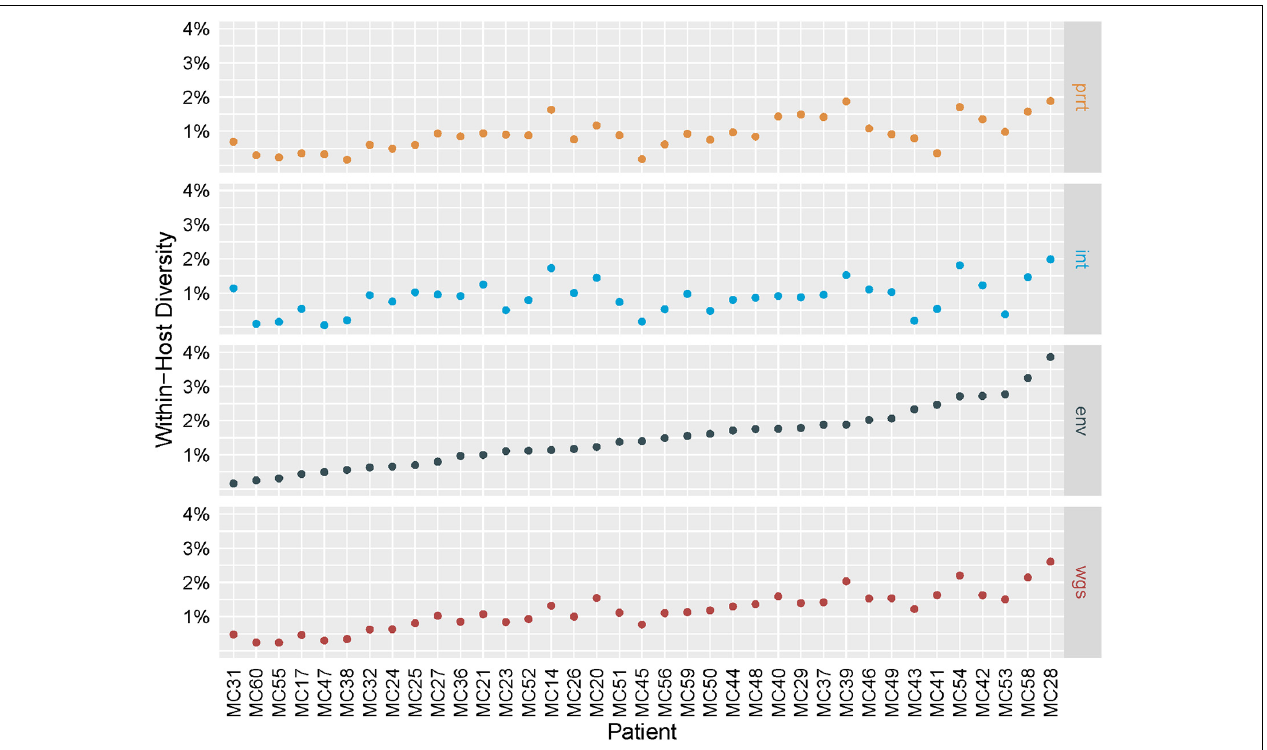
FIGURE 2 | Intra-host genetic diversity by genomic region. Intra-host genetic diversity ( Y axis; defined as the average percent difference across all pairwise comparisons of the 500 profile-sampled nucleotide sequences for an individual) of the four examined genomic regions (gray boxes on the right) in the 37 sampled individuals ( X axis) is highest in env for most individuals and lies within the range of previously reported values.